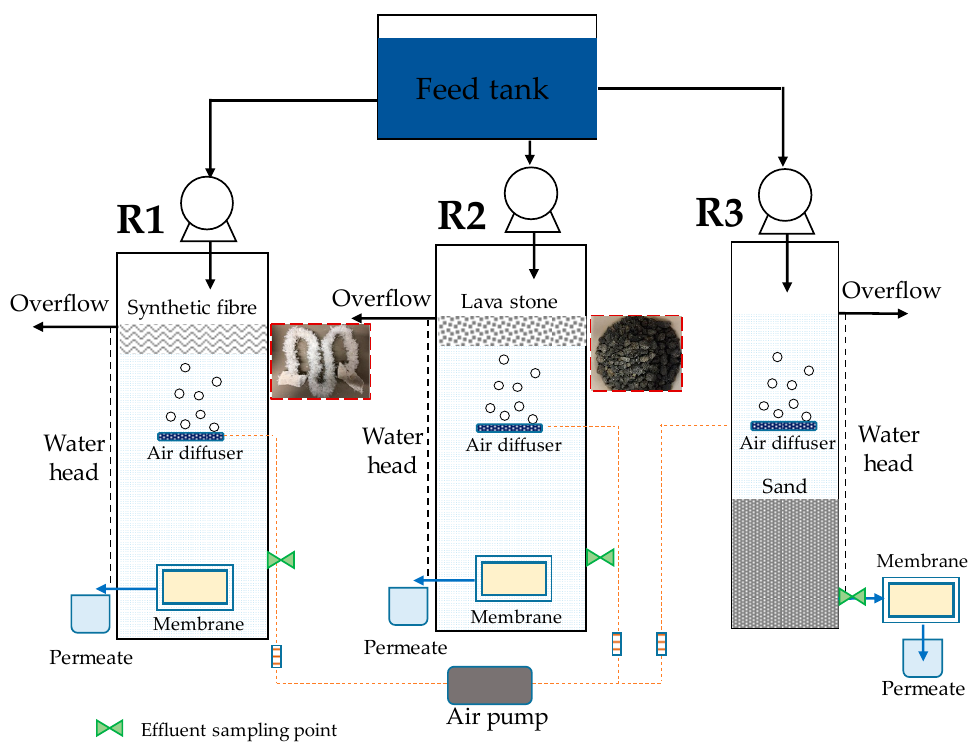
Figure 1. Schematic diagram of the GDM reactors.